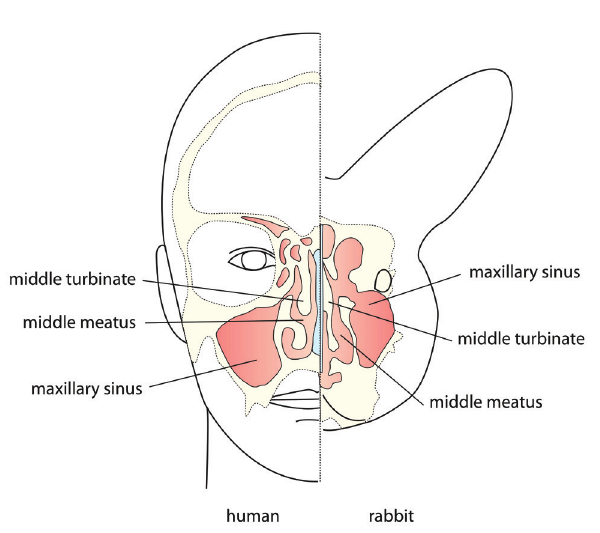
Figure 1. Comparison of human and rabbit sinus anatomy. Half views of the paranasal sinuses of rabbit and human are shown (light blue =